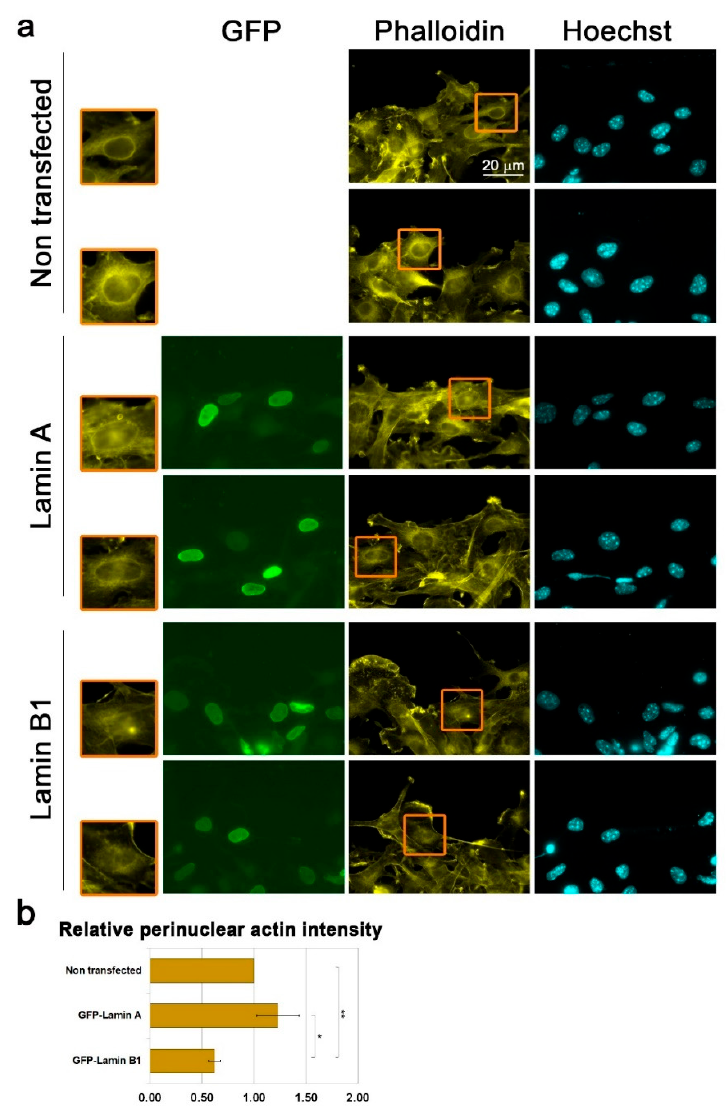
Figure 3. Increased lamin B1 levels interfere with the perinuclear actin rim levels. ( a ) Fluorescence microscope micrographs of non-transfected and over-expressing GFP-fused lamin A or GFP-fused lamin B1 confluent B16–F10 cells induced to migrate in the wound healing assay for 3 h stained for filamentous actin (Phalloidin) and DNA (Hoechst). The edge of the scratch is in the top region of each micrograph. The nuclei in the orange rectangles are magnified on the left side. Scale bar: 20 µ m. ( b ) Quantification of the e ff ect of lamins over-expression on perinuclear actin filaments. In each experiment, 20–40 cells of each transfection were measured for the Phalloidin signal at the nuclear periphery. The average mean intensity was calculated and normalized to non-transfected cells. The average mean intensity in three independent experiments ± s.e. is presented. Statistical significance was evaluated by the Student’s t -test, * p < 0.05, ** p <